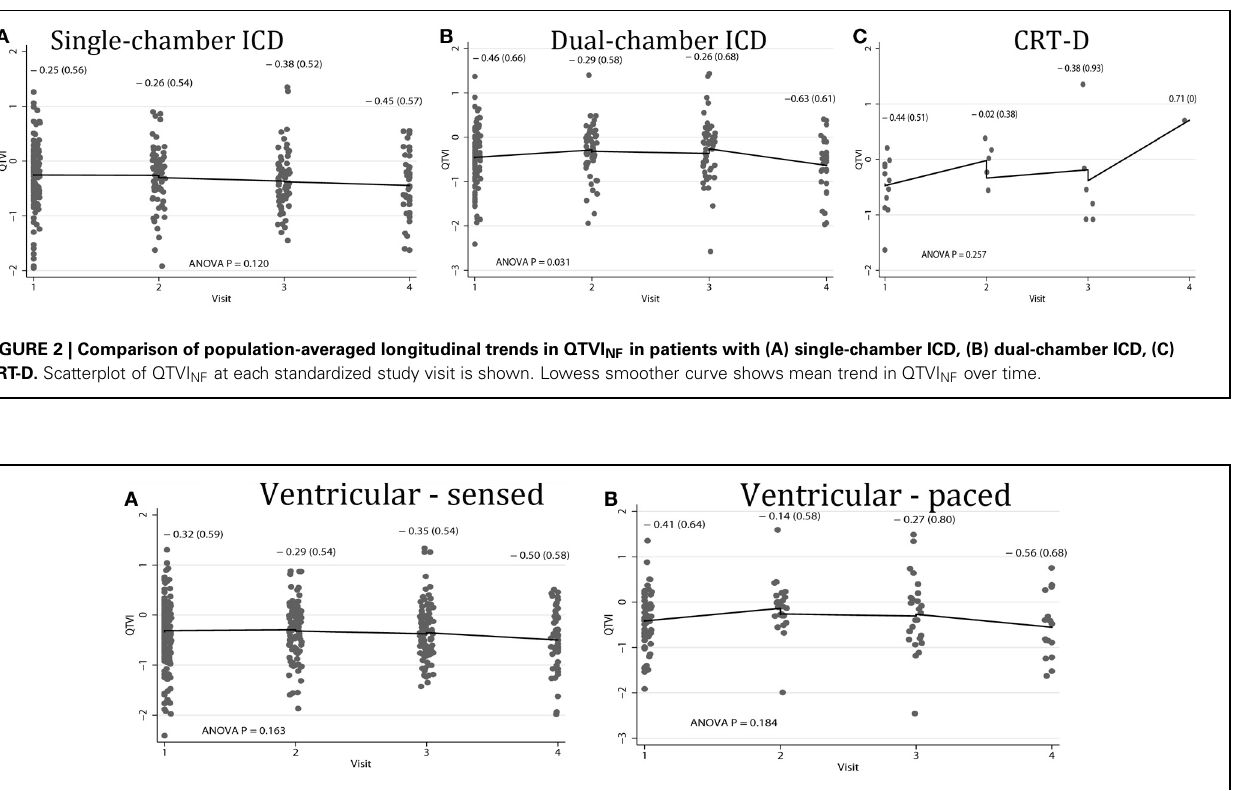
FIGURE 3 | Comparison of population-averaged longitudinal trends in QTVI NF in patients with (A) presenting ventricular-sensed (VS), and (B) presenting ventricular-paced (VP) sinus rhythm. Scatterplot of QTVI NF at each standardized study visit is shown. Lowess smoother curve shows mean trend in QTVI NF over time.